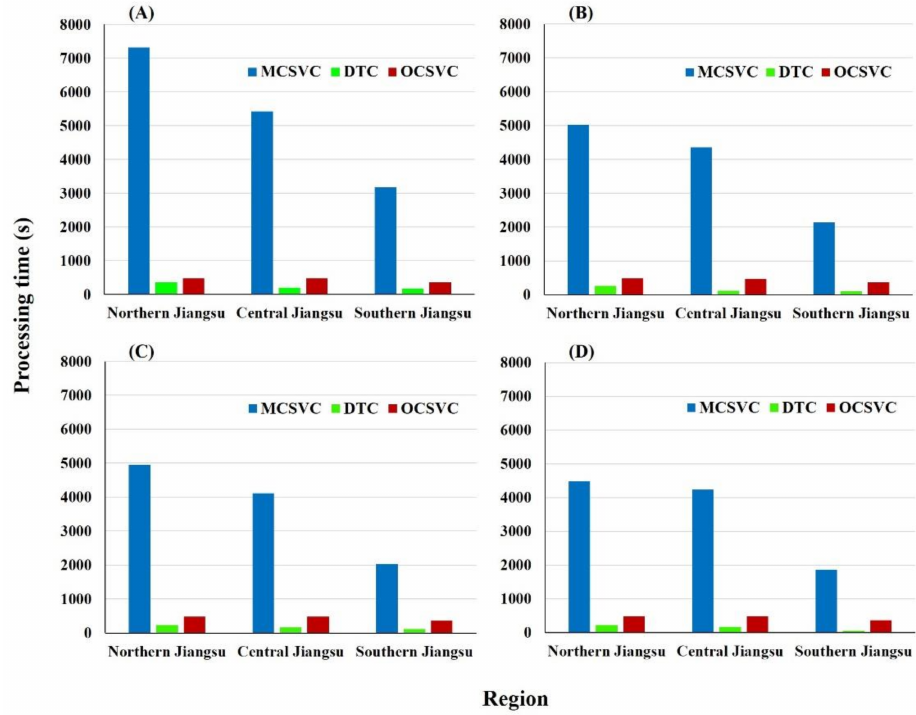
Figure 11. The classification efficiency of MCSVC, DTC and OCSVC as measured by processing time for Norther, Central, and Southern Jiangsu. Four groups of tests were designed by reorganizing all the 14 classes ( A ) of training samples into four classes ( B ), three classes ( C ), and two classes ( D